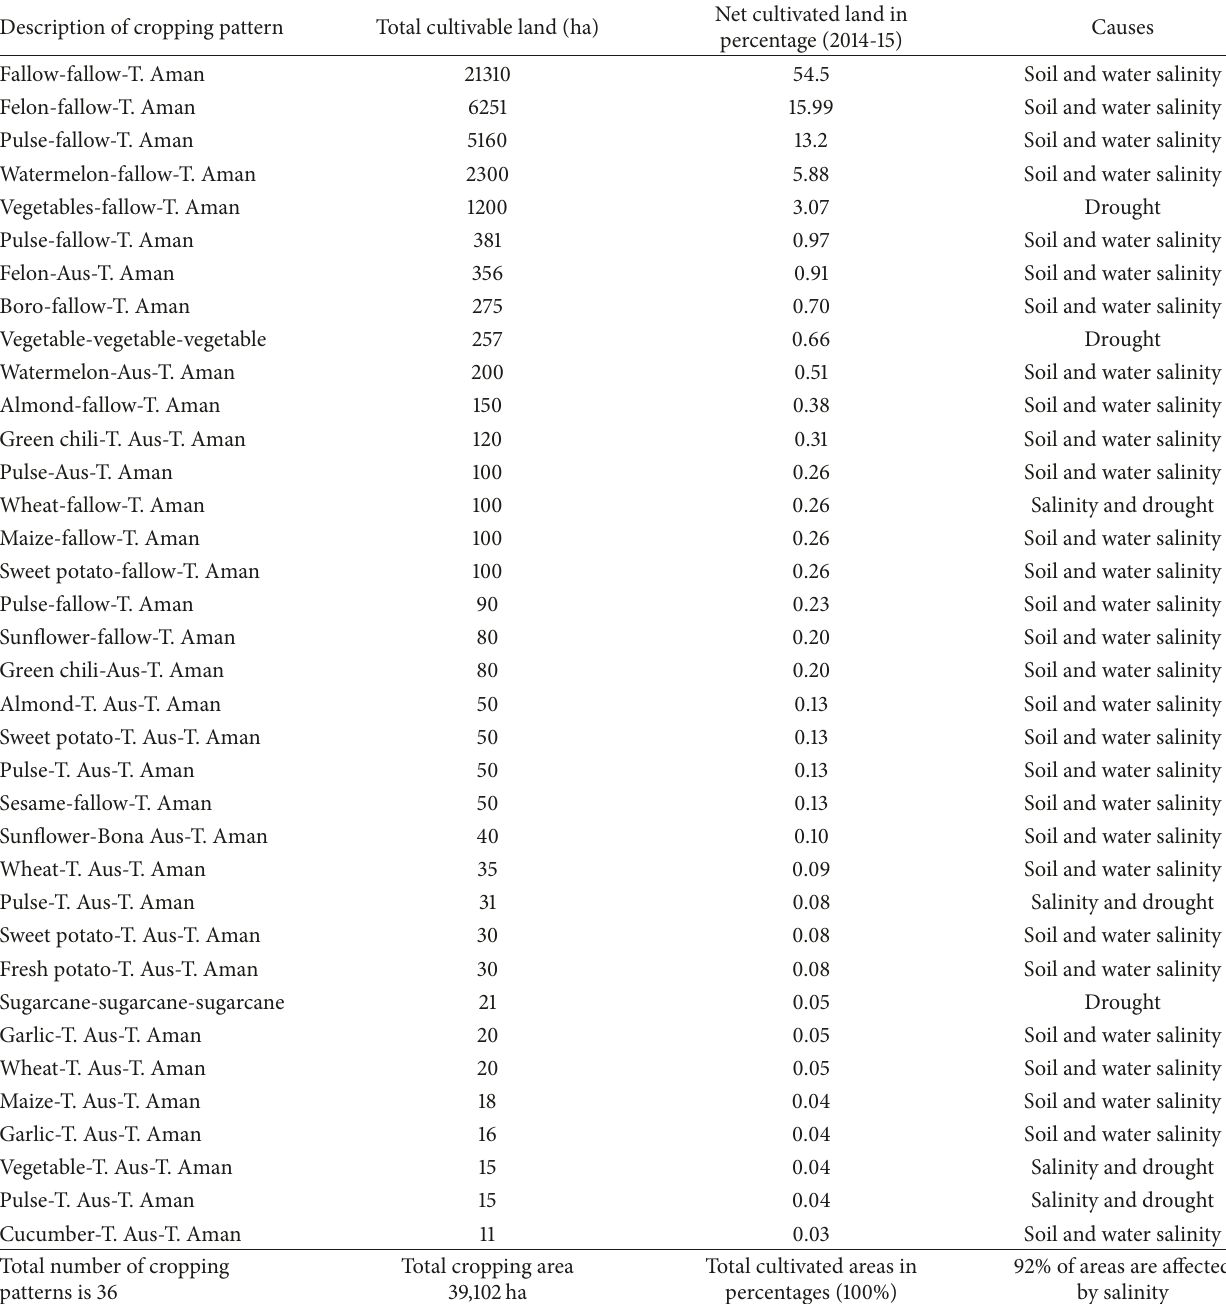
Table 9: Effect of soil and water salinity on cropping patterns at Kalapara coastal